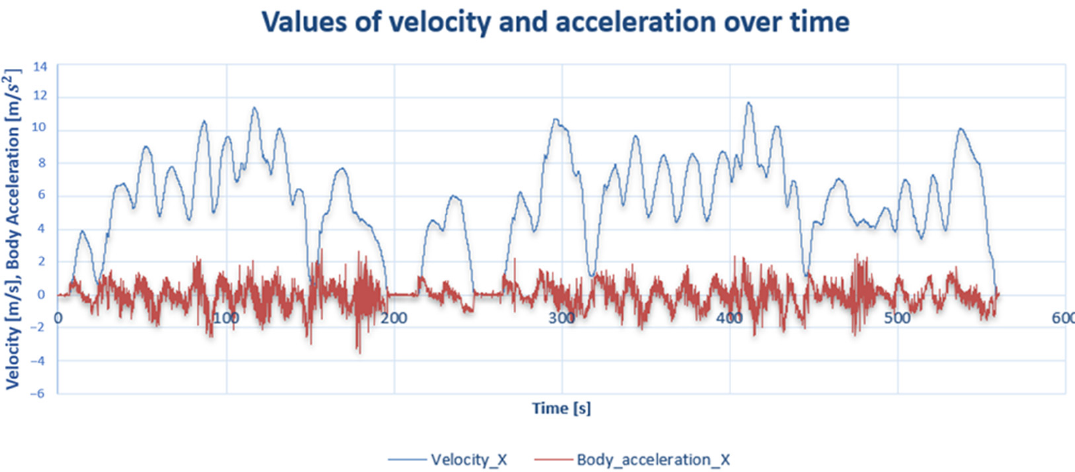
Figure 8. Values of velocity and acceleration over time.